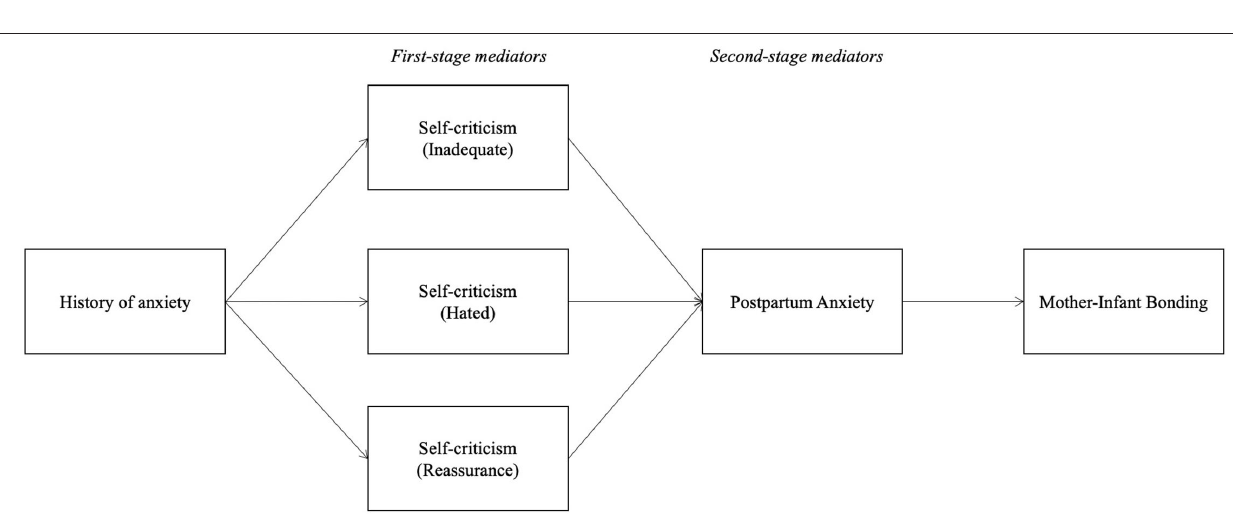
symptoms were entered as independent variables (each